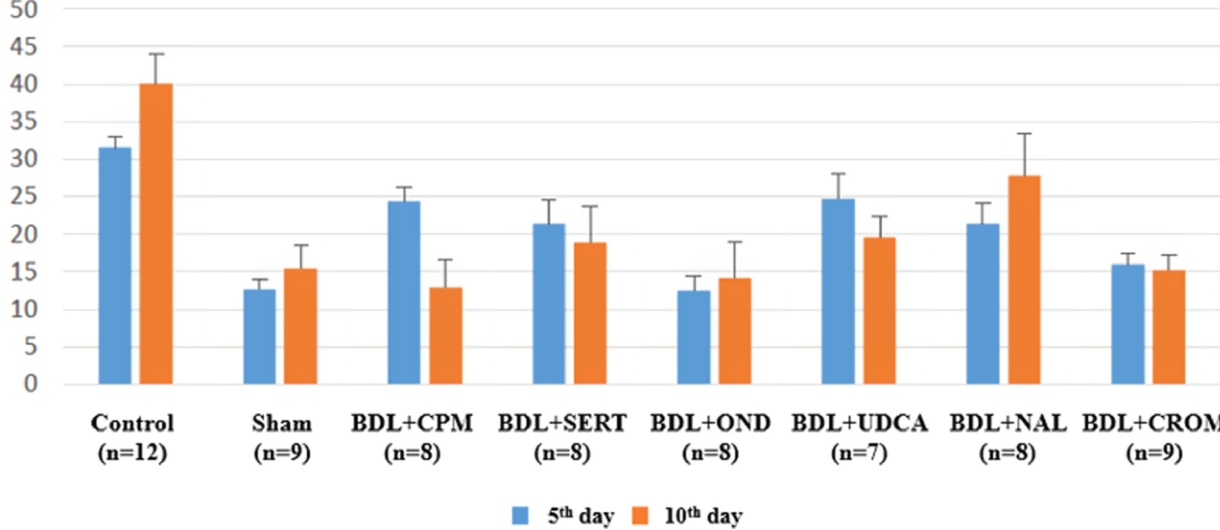
Figure 2. The main duration of itching time for the whole groups on the fifth and tenth days is